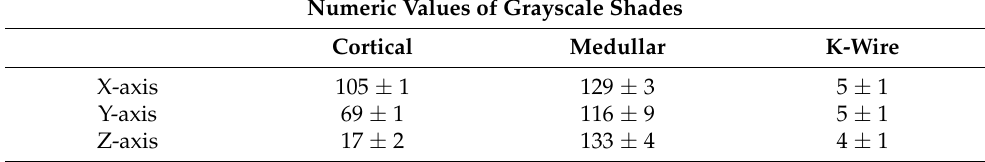
Figure 11. X-ray images taken from the same PLA-PU model-bone specimen in all three planes. The elevated attenuation caused by the increased sample thickness is observable with naked eye. The black star indicates the K-wire rod, and the dashed black and white lines represent the border of the simulated cortical and medullar regions. Table 1. Quantified grayscale values on the standard 8-bit scale (integer from 0 (black) to 255 (white)) of different areas of the specimen in all three planes; values are mean + standard deviations obtained from five standalone